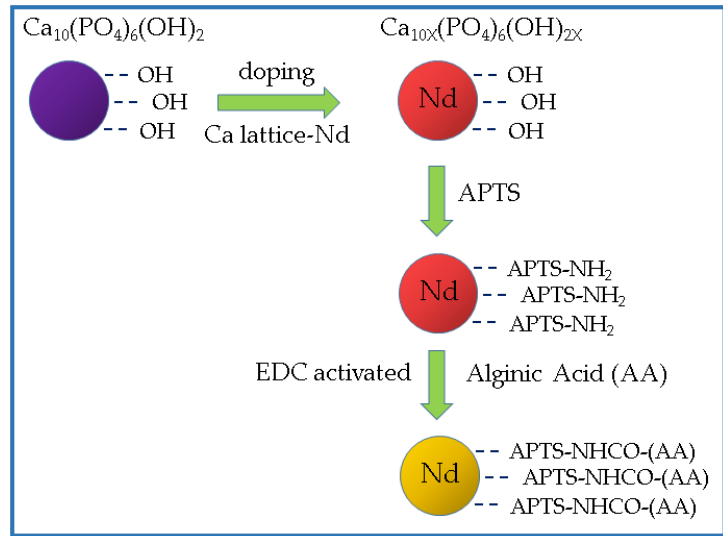
Figure 14. Scheme sowing the doping with Nd 3+ cations of nHAp particles previously loaded